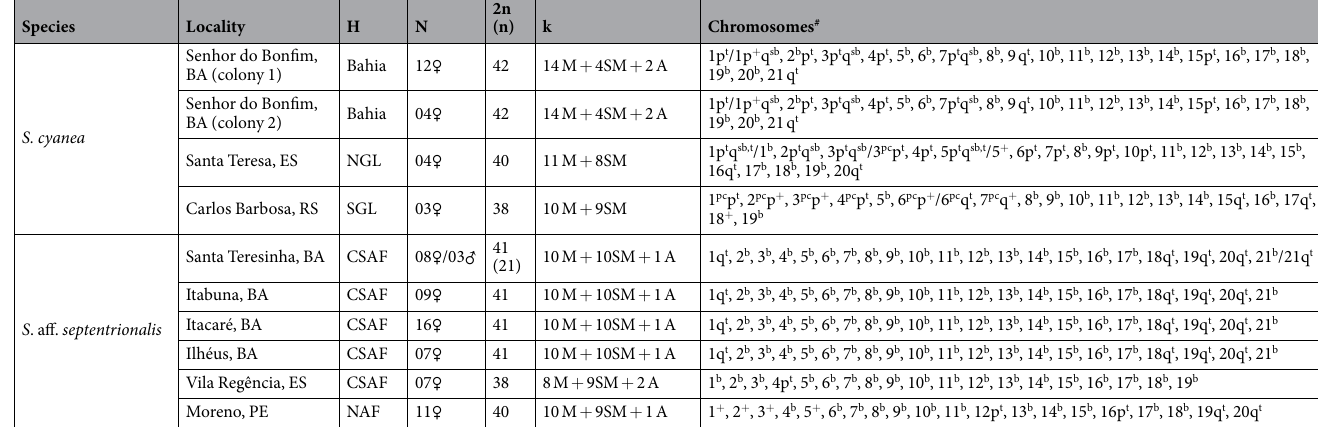
Phylogeographical structure, Bayesian phylogenetics and genetic diversity. The unrooted hap- lotype networks, BI, and AMOVA tests revealed contrasting degrees of phylogeographical structure between S . cyanea and S . aff. septentrionalis (Fig. 2, Tables S4 and S5). Despite the BI for S . cyanea exhibiting a lack of reciprocal monophyly, and hence no evidence for strong structuring, our unrooted haplotype network suggested a shallow split in the mtDNA-only haplogroups coincident with the neotectonic Guapiara lineament located in the southern state of São Paulo (e.g., Saadi et al . 68 ; Thomé et al . 22 ) (Figs 1, 2a and b). This result agrees with our